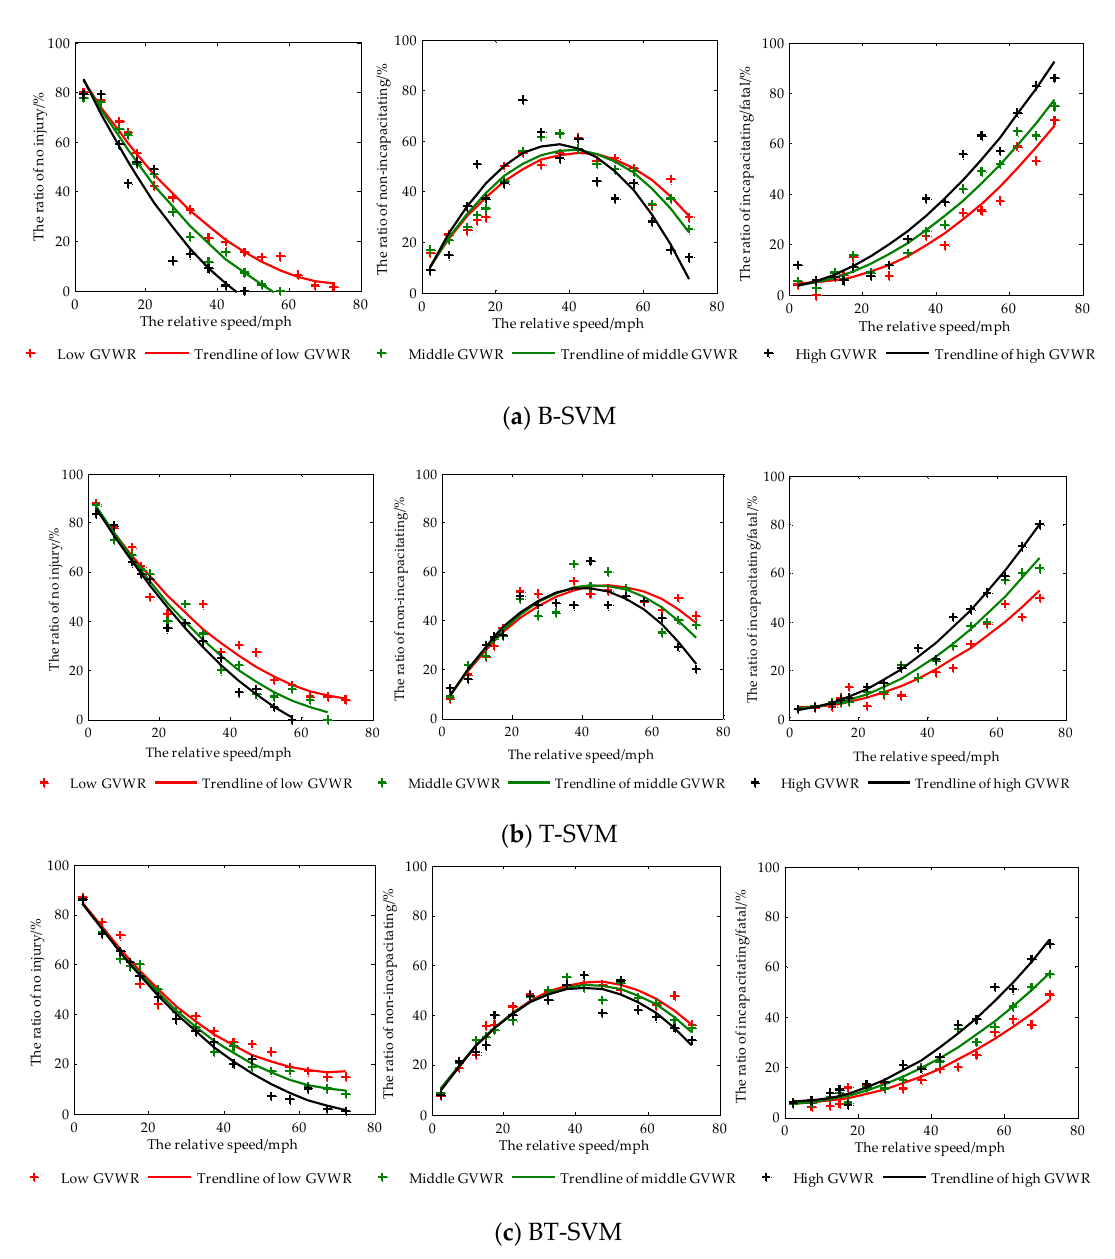
Figure 9. The changing trend of crash injury severity ratio under different conditions. ( a ) With the B-SVM model, the changing trend of each injury severity ratio with the REL_SPEED when the GVWR is in different ranges. ( b ) With the T-SVM model, the changing trend of each injury severity ratio with the REL_SPEED when the GVWR is in different ranges. ( c ) With the BT-SVM model, the changing trend of each injury severity ratio with the REL_SPEED when the GVWR is in different ranges. From left to right, each column represents the changing trend of no injury ratio, non-incapacitating ratio and incapacitating/fatal ratio with the REL_SPEED when the GVWR is in different ranges, respectively.